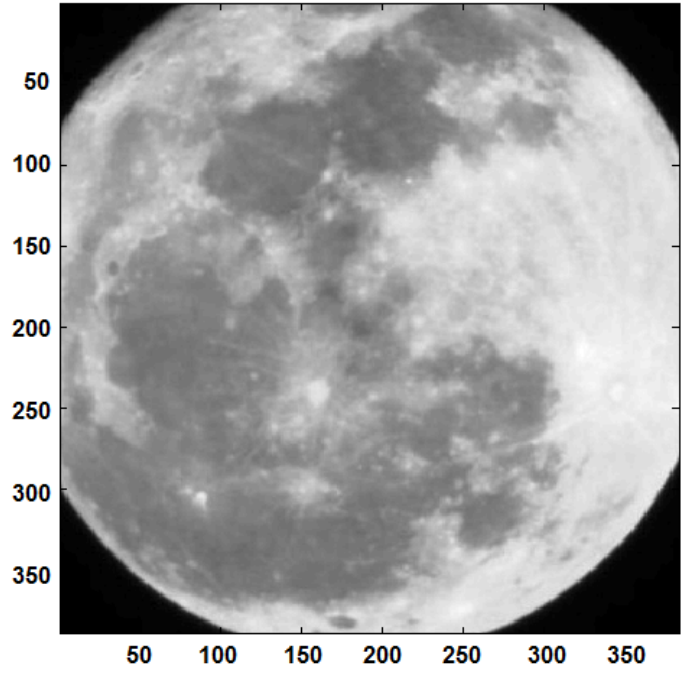
Figure 9. Example 1: Original